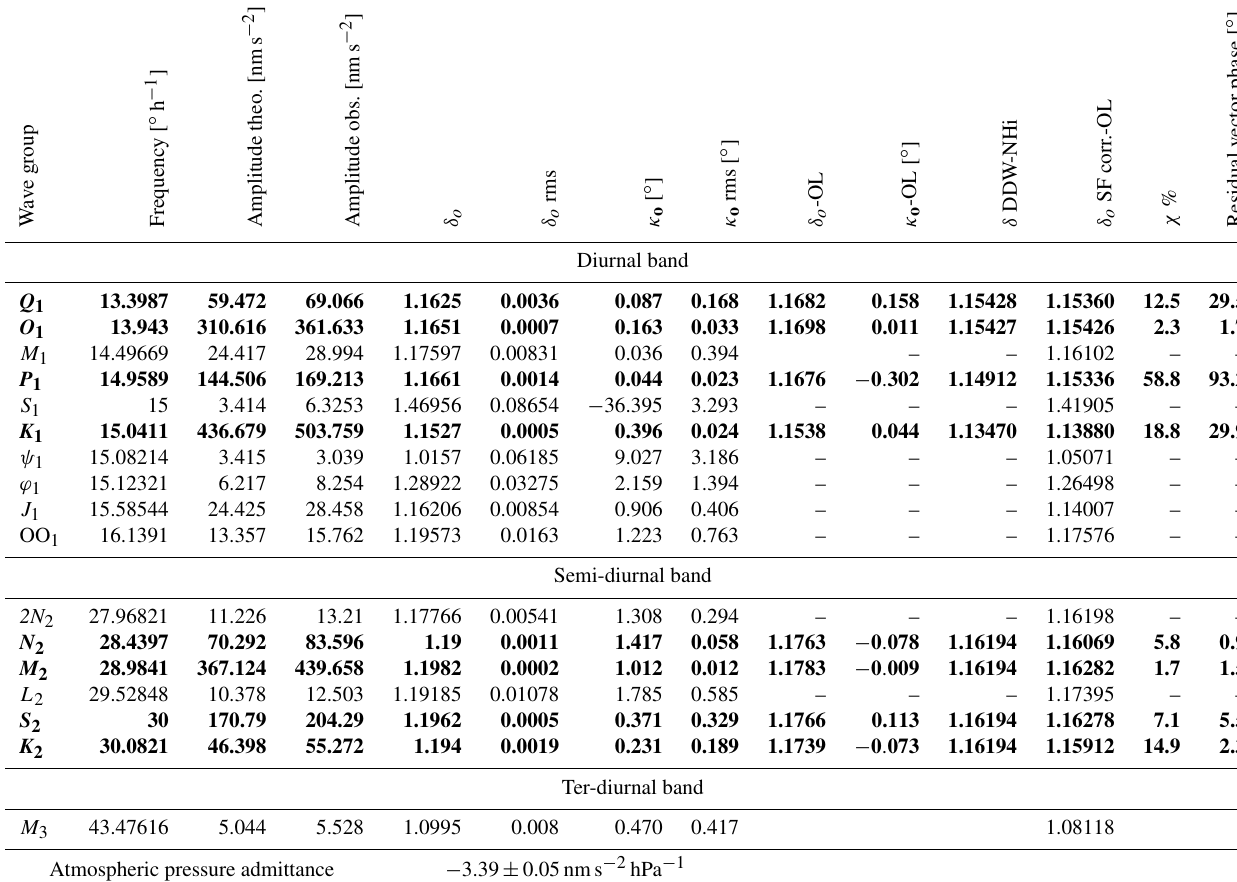
Table A1. Tidal analysis results. δ o = δ observed; κ o = phase observed; δ o -OL = δ observed corrected for oceanic loading (OL); κ o -OL = phase corrected for OL; δ DDW-NHi = theoretical response; δ o SF corr.-OL = δ observed corrected for Scale Factor and OL; χ = residual vector length. For definition of χ and phase residuals, please refer to Meurers et al. (2016). Rows in bold = FES2014b correction